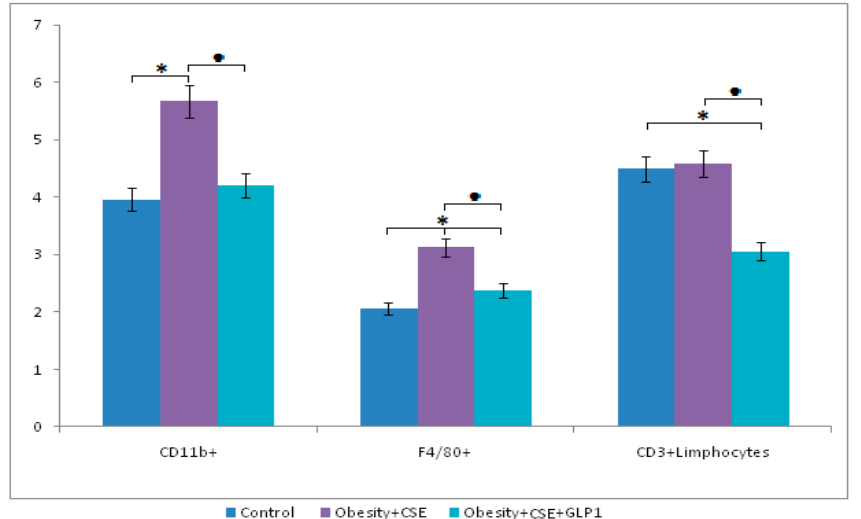
Figure 6. The content of CD11b + and F4/80 + monocytes, and CD3 + T-lymphocyte in the blood of control mice, obese mice exposed to CSE, obese mice exposed to CSE and receiving GLP-1. * - significance of difference compared with control ( p < 0.05); ■ - significance of difference compared with the obesity + CSE group ( p < 0.05).